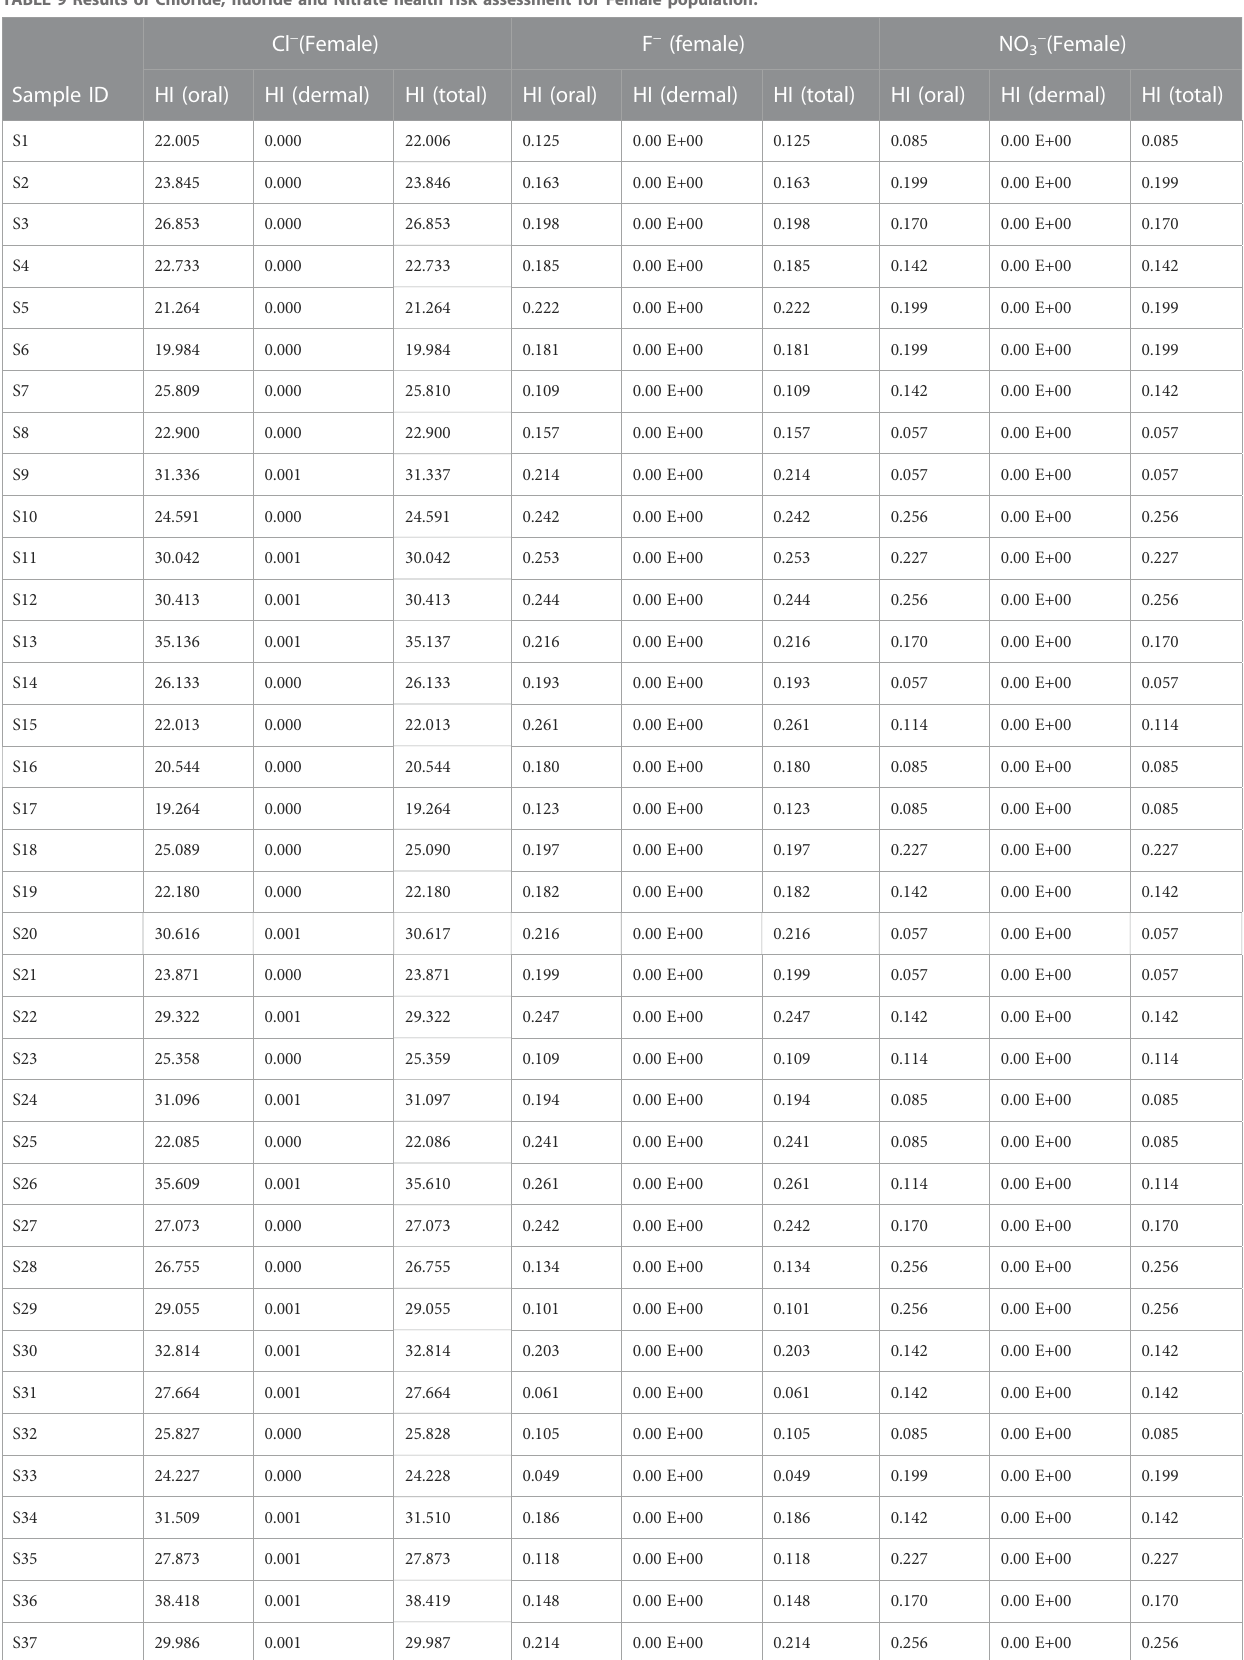
TABLE 9 Results of Chloride, fl uoride and Nitrate health risk assessment for Female population. Cl − (Female) F − (female) NO 3 − (Female) Sample